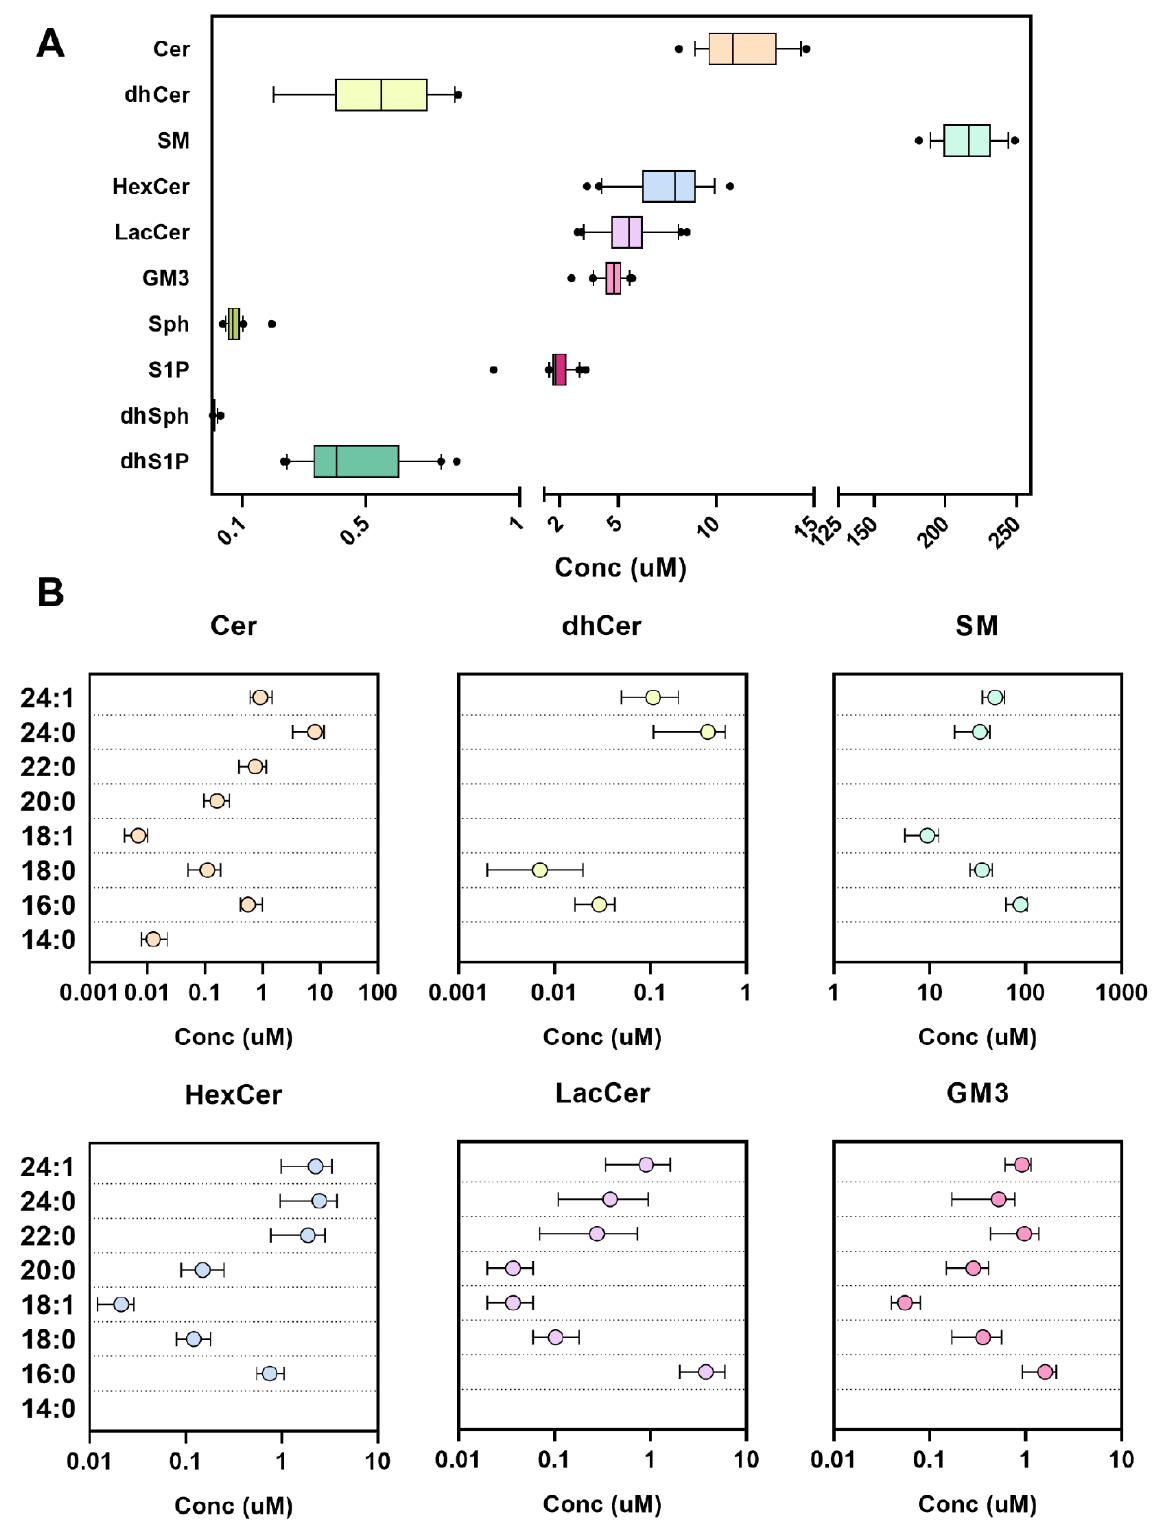
Figure 4. Plasma sphingolipids concentration in healthy volunteers ( n = 20). ( A ) Concentrations of complex sphingolipids and free sphingoid bases (min–max, line at mean, dots represent the 10–90th percentile) as the sum of the species in each class and ( B ) divided according to their fatty acid composition (mean ± SD).